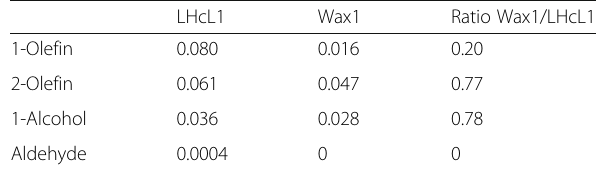
Table 11 Average number of class groups per chain in LHcL1